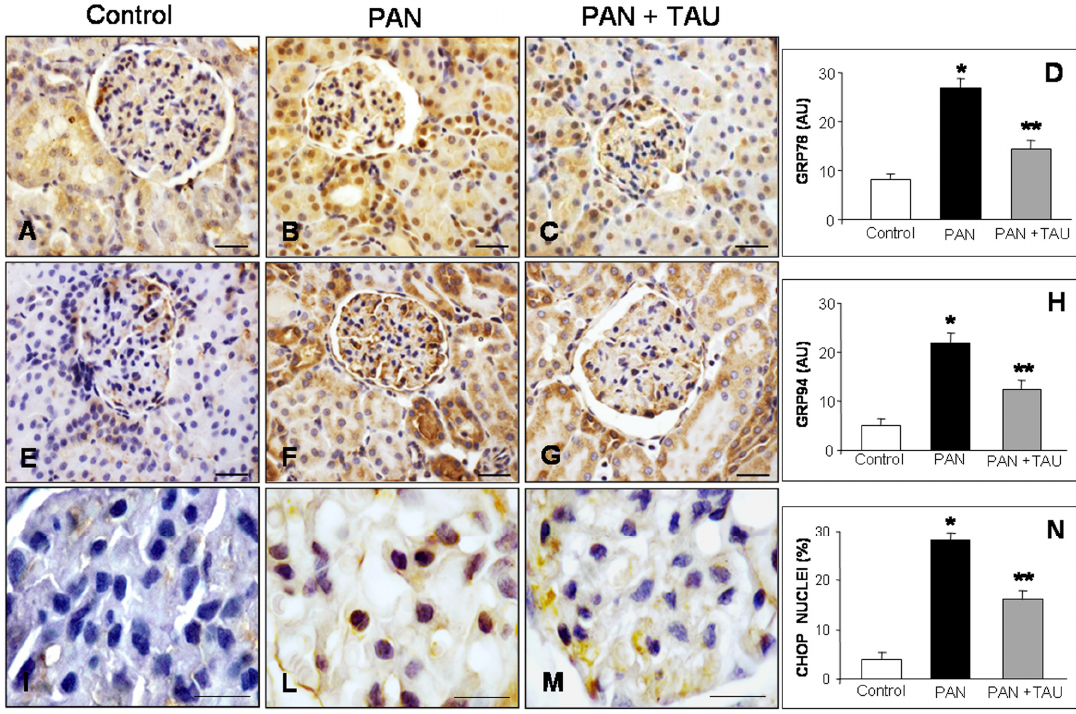
Figure 3. Endoplasmic reticulum stress makers. ( A – C ) GRP78, ( E – G ) GRP94, ( I – M ) C/EBP homologous protein (CHOP) in ( A , E , I ) control rats, ( B , F , L ) PAN nephrotic rat model are ameliorated by ( C , G , M ) TAU pre-treatment. Bar represents 20 µm. Quantitative analysis of immunostaining for ( D ) GRP78 and ( H ) GRP94, expressed as arbitrary units, and ( N ) of nuclear positive percentage of CHOP immunostaining. * p < 0.05 statistically significant versus control group; ** p < 0.05 significant versus PAN group.